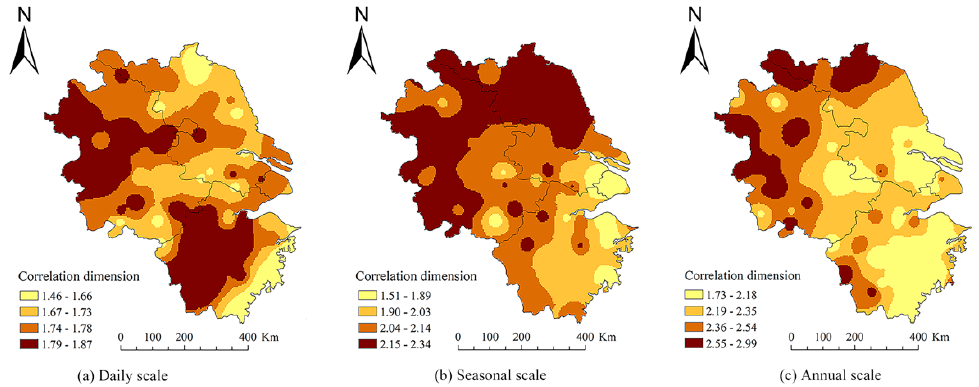
Figure 9. The spatial pattern of complexity of the temperature process at daily ( a ), seasonal ( b ), and annual ( c ) scales.